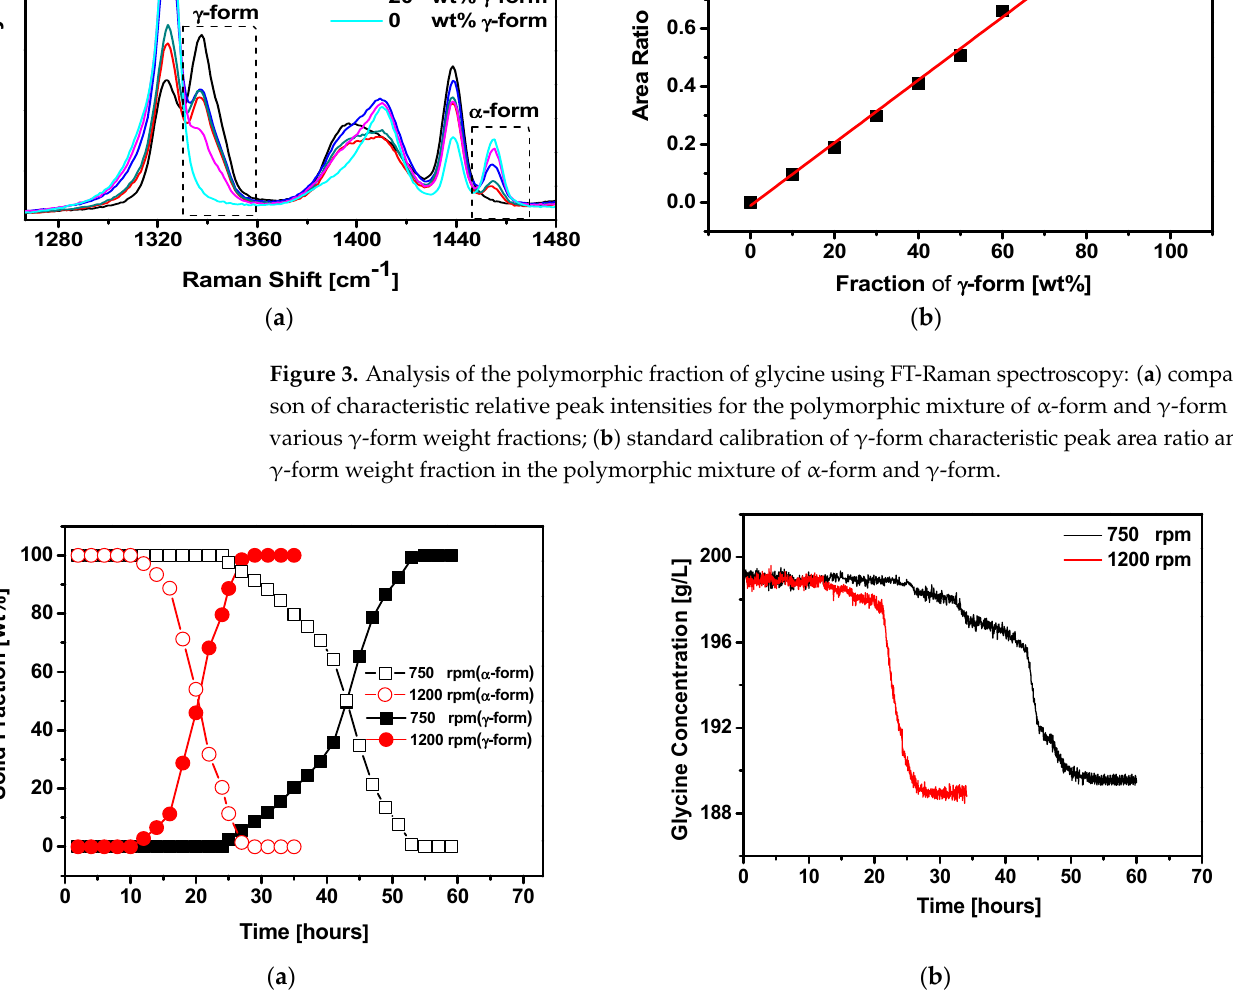
Figure 4. Influence of agitation speed on the polymorphic phase transformation of glycine α -form to γ -form. ( a ) Solid fraction of γ -form and α -form glycine; ( b ) glycine solution concentration during crystallization. The crystallization temperature, NaCl concentration, and seed concentration were fixed at 20 °C, 80 g/L, and 60 g/L, respectively.